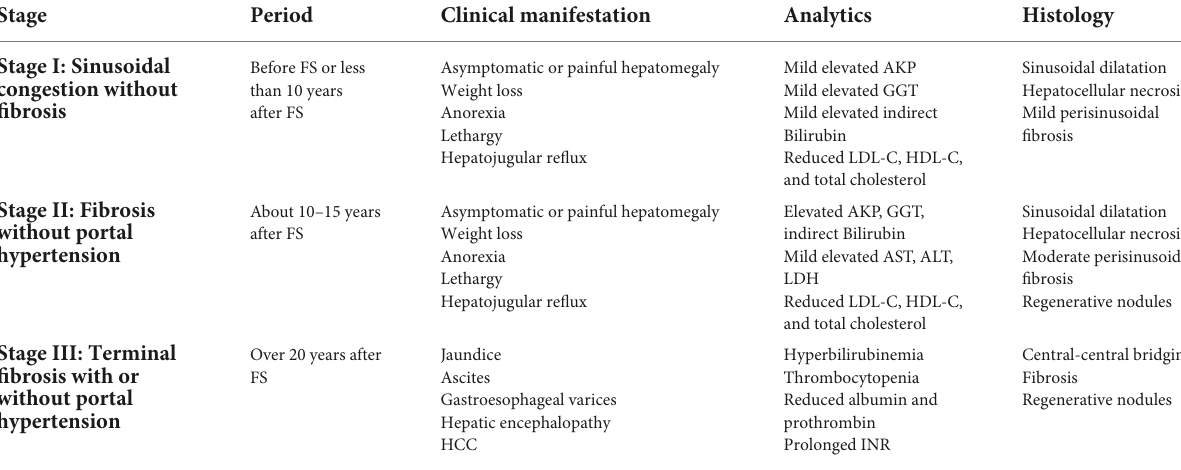
TABLE 1 Progression of Fontan-associated liver